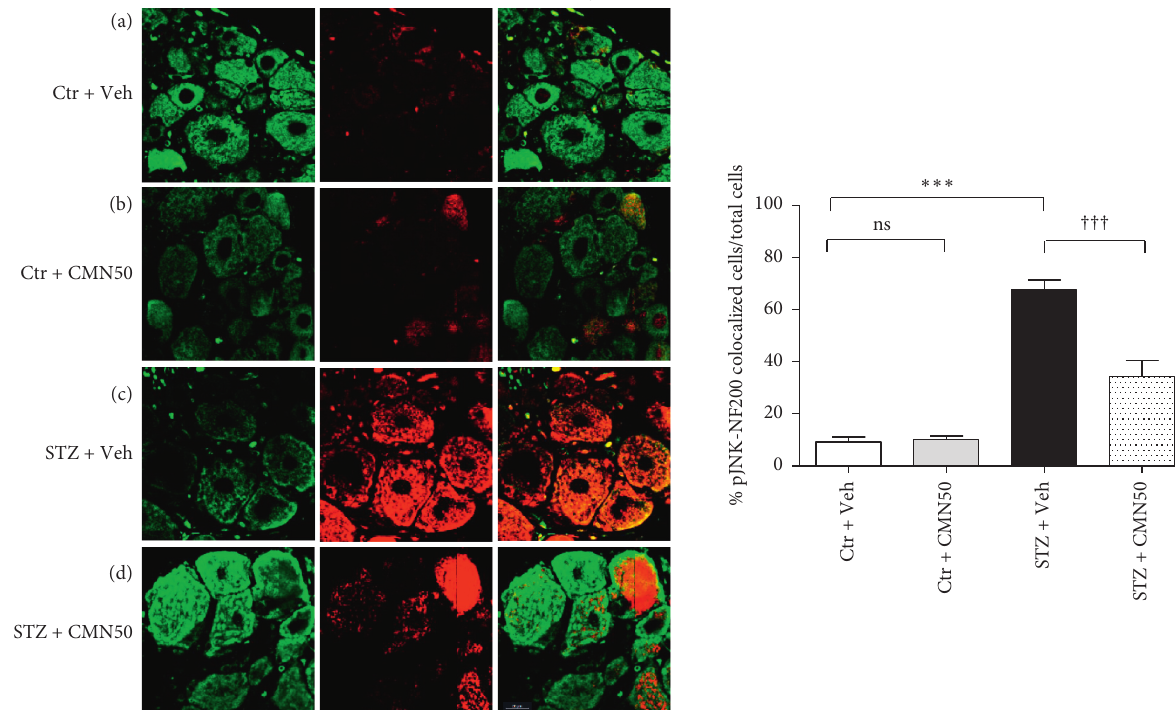
Figure 5: Immunohistochemistry for pJNK (red, pJNK antibody) expression in the neurons of the dorsal root ganglion (DRG) (green, NF200 antibody). Treatment of streptozotocin- (STZ-) induced diabetic neuropathic pain rats (STZ+CMN50) with 50mg/kg/day of curcumin (CMN) for 4 consecutive weeks normalized pJNK expression in the neurons of the DRG. (a) Control group (Ctr+Veh, n � 4), (b) curcumin-treated control group (Ctr+CMN50, n � 4), (c) STZ-induced diabetic neuropathic pain rats (STZ+Veh, n � 4), and (d) cur- cumin-treated STZ-induced diabetic neuropathic pain rats (STZ+CMN50, n � 4). ∗∗∗ p < 0 . 001 compared to the Ctr+Veh group; ††† p < 0 . 001 compared to the STZ+Veh